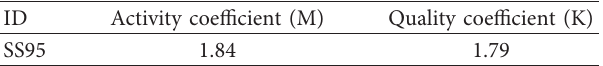
Table 5: The activity coefficient (M) and quality coefficient (K) of